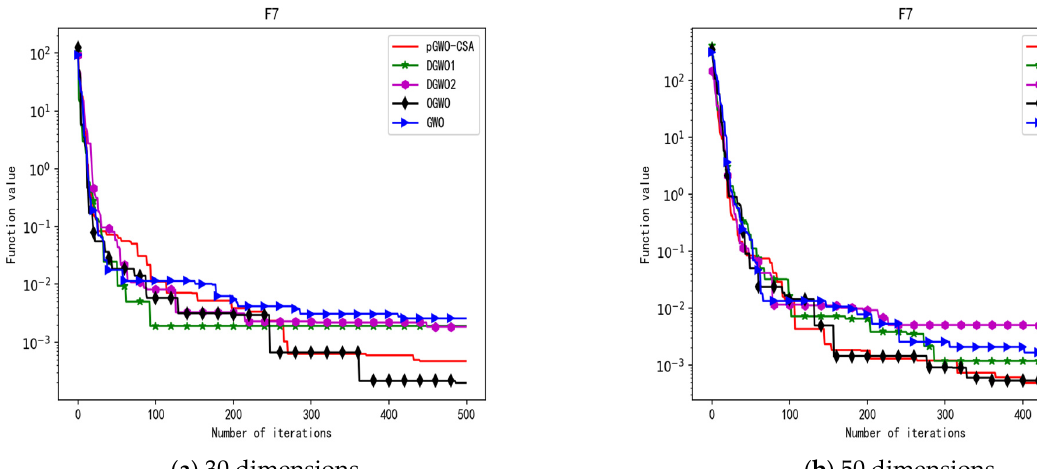
25 of 37 Figure 24. Convergence curve of test function F5.